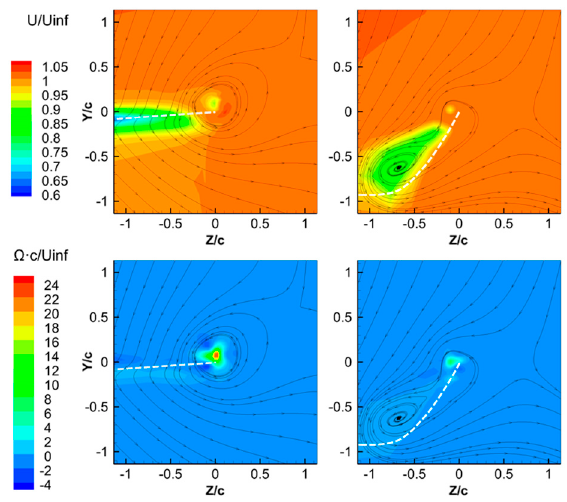
Figure 19. Time averaged axial-velocity ( top ) and axial vorticity ( bottom ) comparison without and with winglet ( α = 10°, X / c = 1).